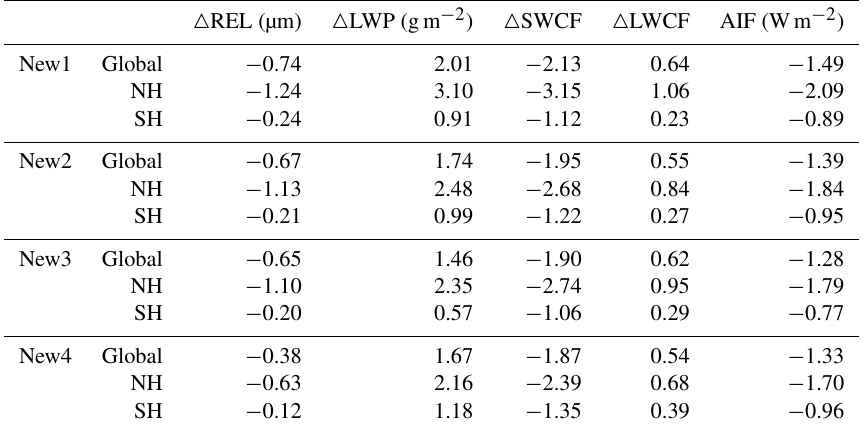
Table 6. Global, Northern Hemisphere (NH), and Southern Hemisphere (SH) annual mean changes of cloud-top effective radius ( (cid:52) REL), liquid water path ( (cid:52) LWP), shortwave cloud radiative forcing ( (cid:52) SWCF), and longwave cloud radiative forcing ( (cid:52) LWCF) between PD and PI, as well as aerosol indirect forcing (AIF, Wm − 2 ) in